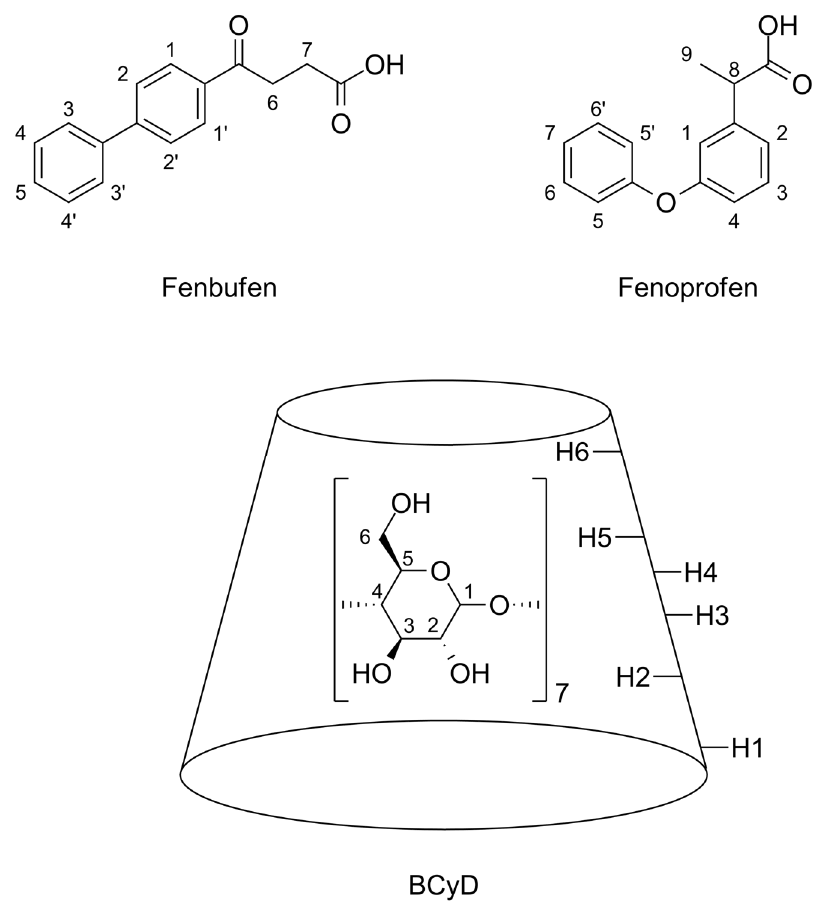
Figure 1. The structural formulae of the studied guest compounds (fenbufen and fenoprofen racemate) and the BCyD host compound, together with the numbering of H atoms of interest for 1 H NMR.